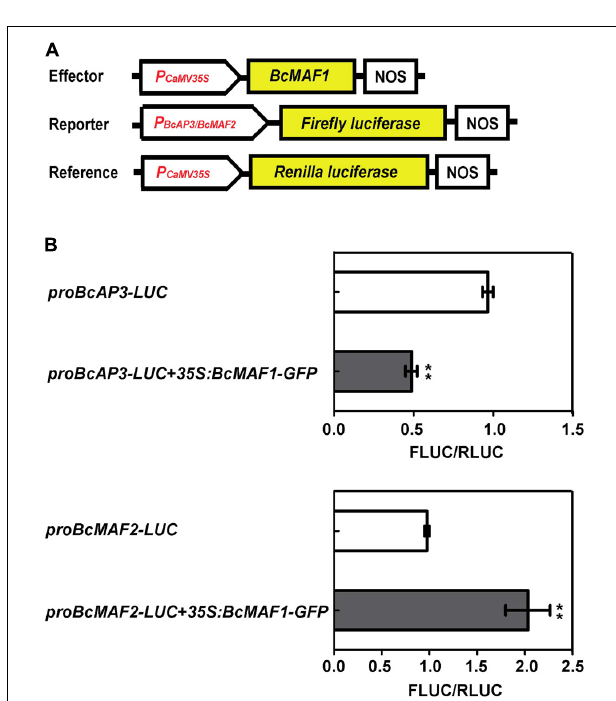
FIGURE 6 | Activation or repression of BcMAF2 or BcAP3 promoter by overexpressing BcMAF1 in the dual luciferase transient assay. (A) Diagram of the effector, reporter, and reference plasmids used in the dual luciferase transient assay. (B) The relative FLUC/RLUC activities of BcMAF2 and BcAP3 promoters activated and repressed by recombinant 35S:BcMAF1-GFP in Arabidopsis protoplasts were detected by Dual-Luciferase R (cid:13) Reporter Assay System. Bars represent the mean ± SEM. The relative FLUC/RLUC activity of the negative control was set at 1. ∗∗ indicate a significant difference at P <